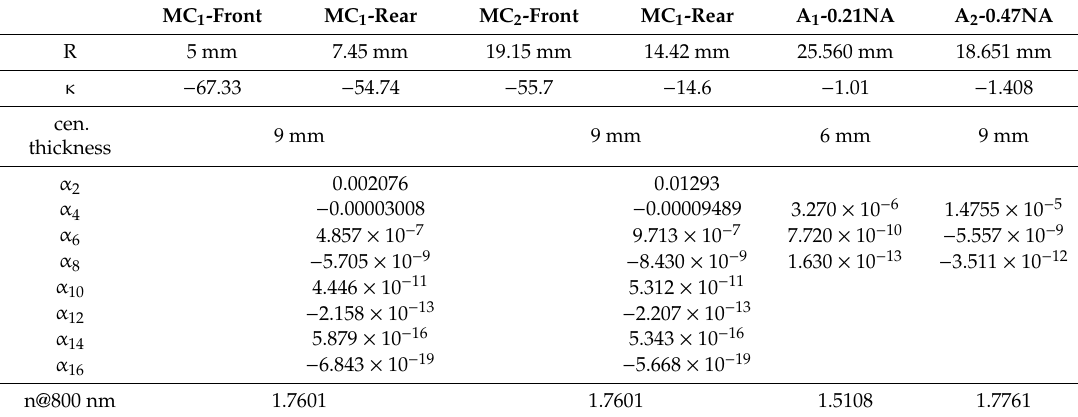
Table 1. A detailed description of all surfaces employed in the simulation using the aspherical lens formula.